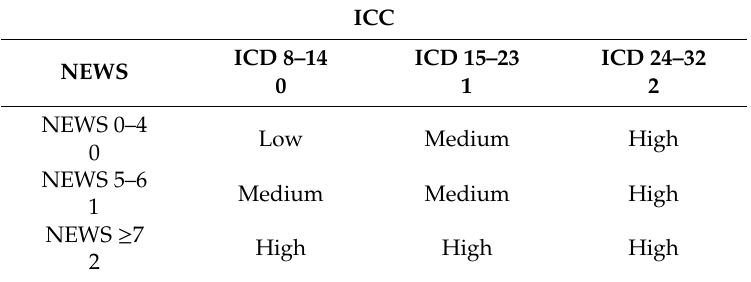
Table 2. Index of caring complexity (ICC) (clinical instability + care dependence).